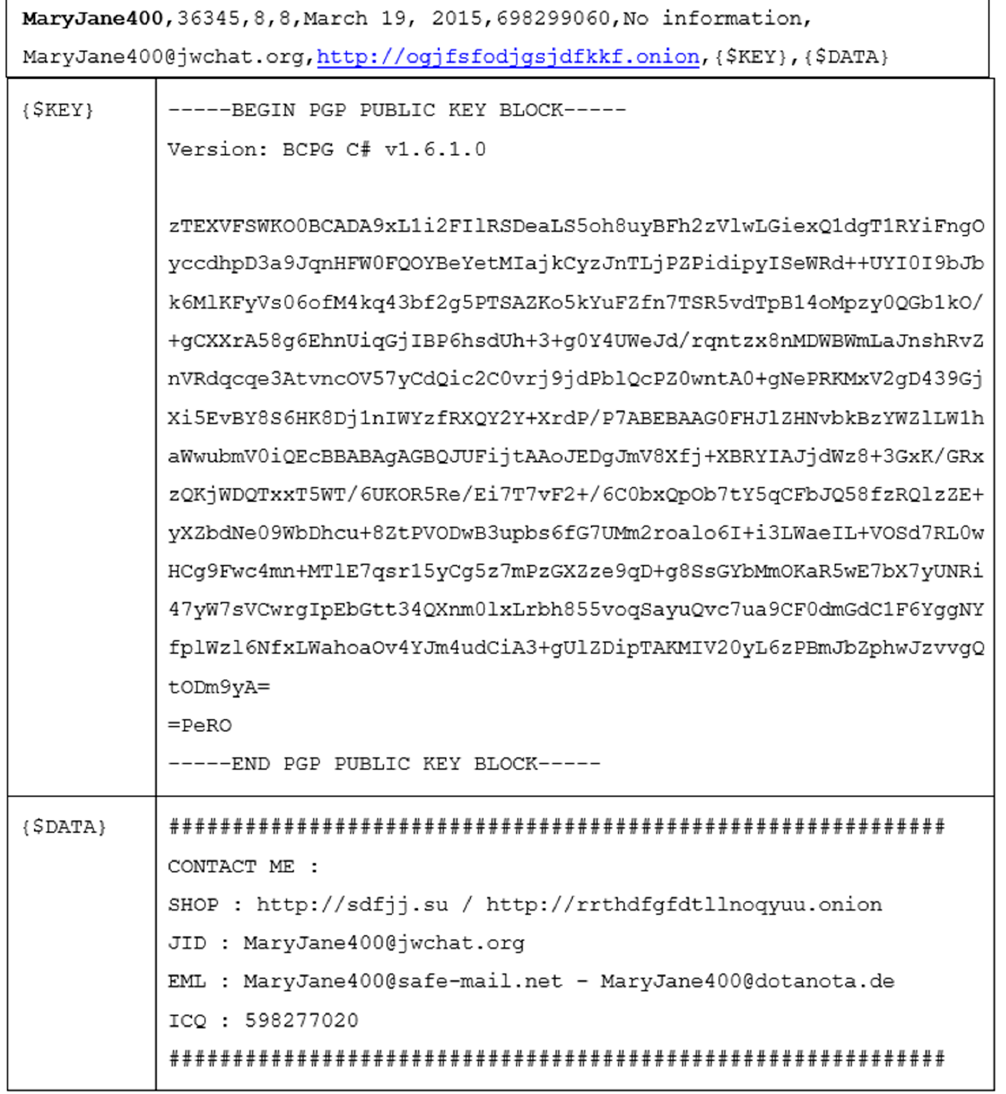
Figure 3. Sample Vendor Data Retrieved from Marketplace.